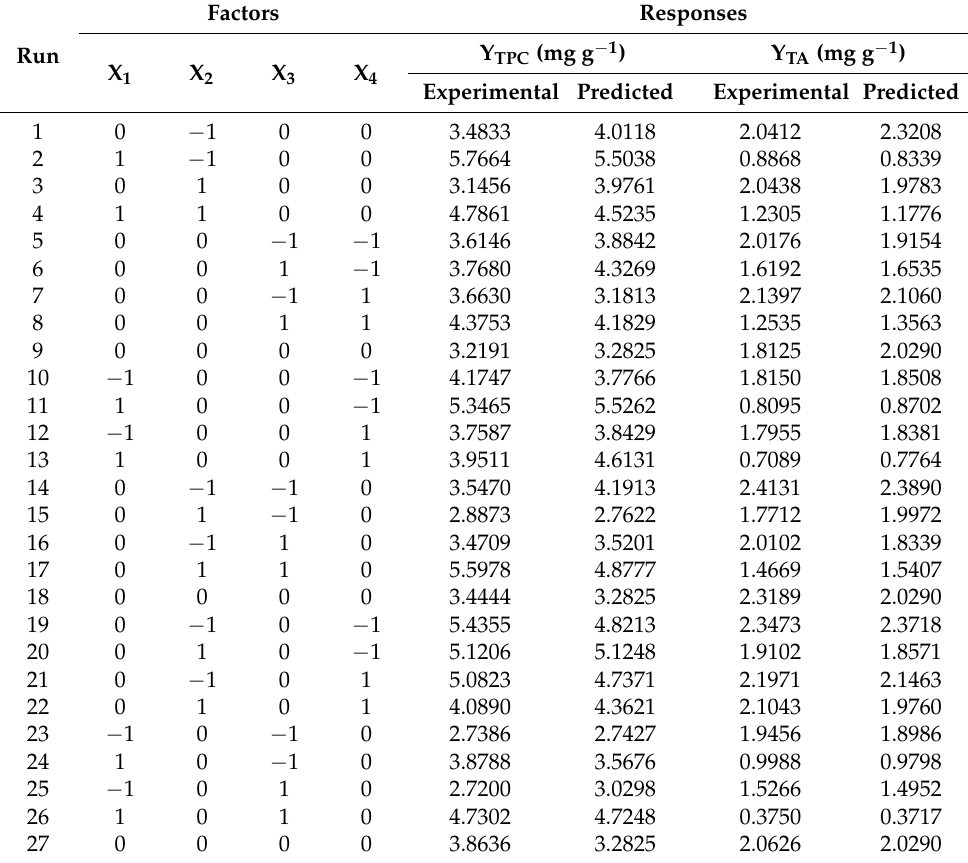
Table 1. Box-Behnken design for total anthocyanins (TA) and total phenolic compounds (TPC). The results correspond to the experimental and the predicted